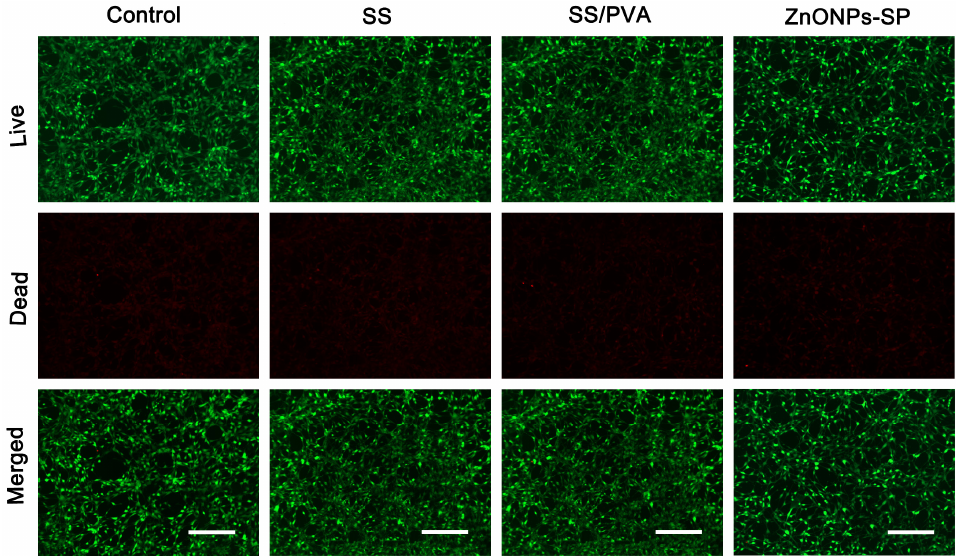
Figure 9. The LIVE / DEAD cells staining assay. PBS was used as control. Scale bar, 200 µ Figure 9. The LIVE/DEAD cells staining assay. PBS was used as control. Scale bar, 200 μ m.